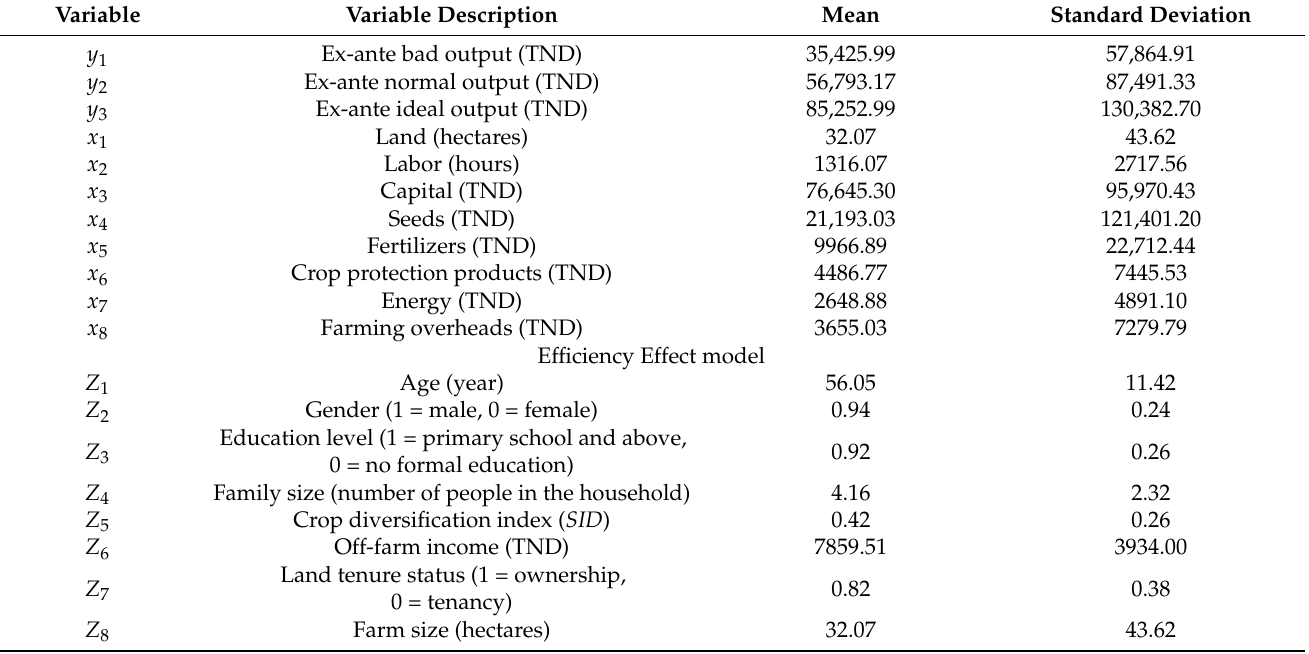
Table 1. Summary statistics for key variables used for efficiency